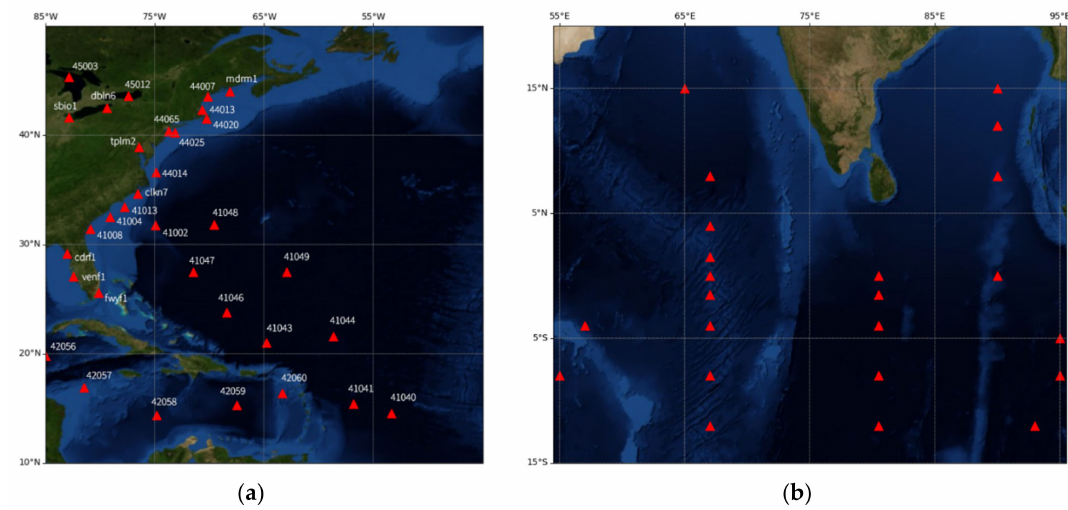
Figure 1. The study areas in this paper with the location of buoys marked in a red triangle: ( a ) Region 1, East Coast of North America; ( b ) Region 2, North Indian